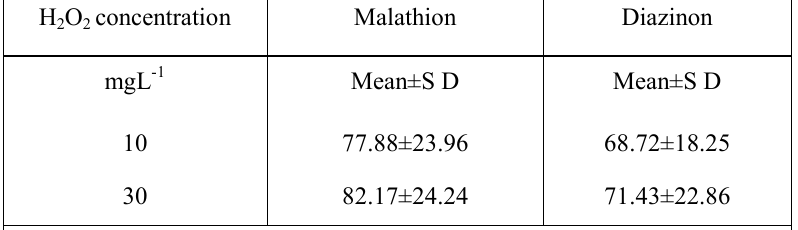
at different hydrogen peroxide concentration.